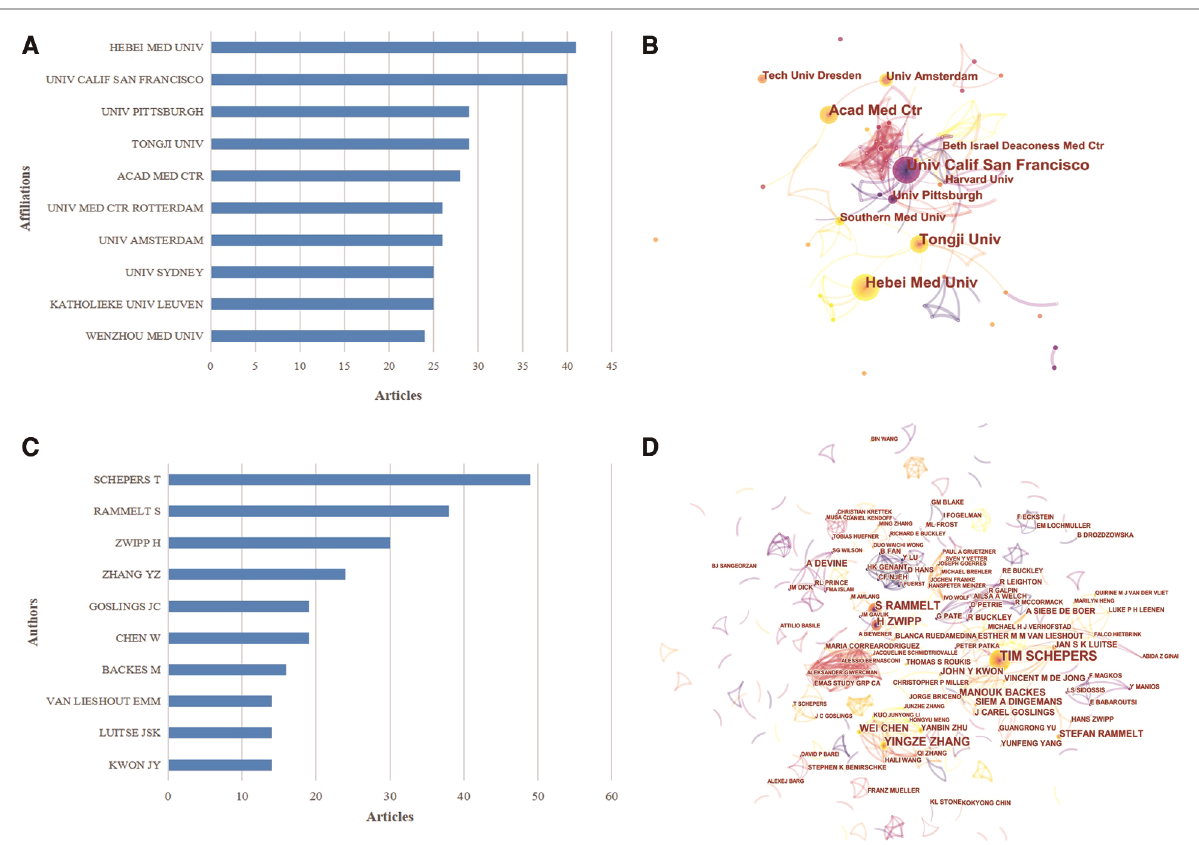
FIGURE 4 The top 10 authors and institutions contributing to calcaneal fracture research. ( A ) The 10 most relevant af fi liations for publications related to calcaneal fracture research. ( B ) Cooperation network map of institutions involved in calcaneal fracture research (generated by CiteSpace). The nodes represent each analyzed object; the greater the frequency of involvement, the larger the node. The color and thickness in the inner circle of the node indicate the occurrence or citation frequency of different time periods. The edge between the nodes and their thickness represent the relationship and strength of co-occurrence or co-citation. ( C ) The top 10 authors and ( D ) the network map of co-cited authors related to calcaneal fracture research. ( D ) Cluster view map of co-cited authors. In the cluster map, cited authors in similar categories are gathered into clusters. Each cluster is labeled with a different color, and the links between nodes represent elements that were cited together. Both maps were generated by